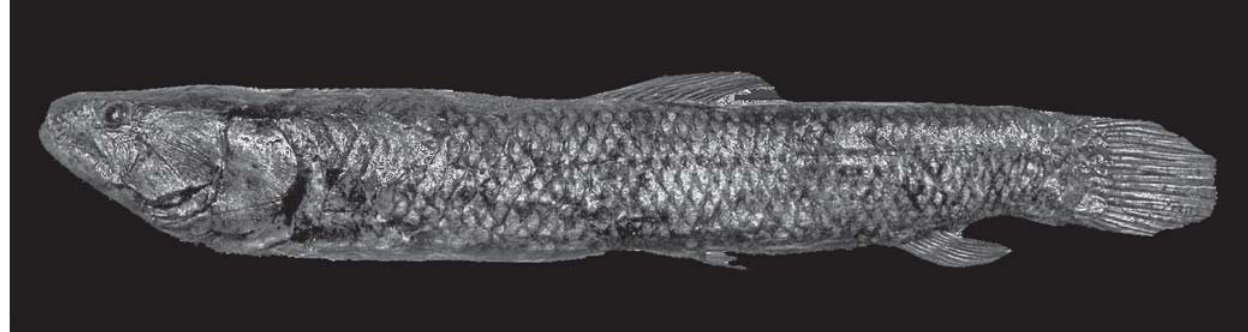
Fig. 11. Hoplias lacerdae , holotype, MNRJ 211, 750.0 mm SL, rio Ribeira de Iguape, São Paulo State,